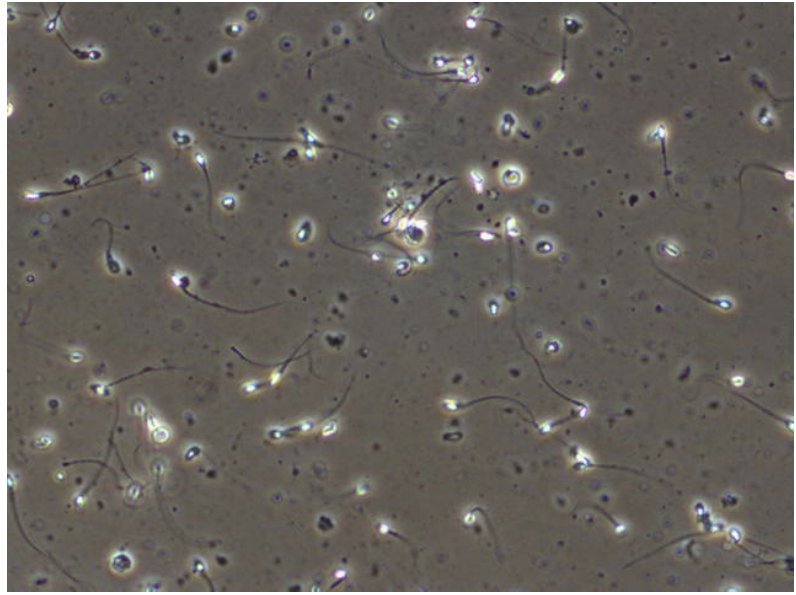
Figure 3. Example image extracted from dataset video